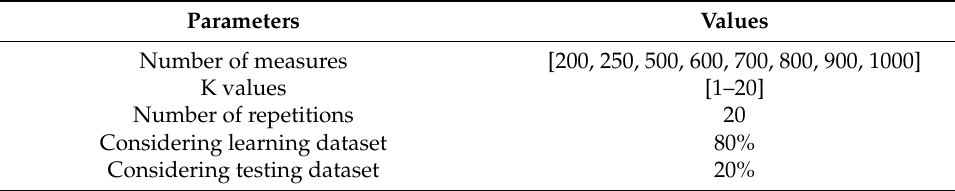
Table 3. Parameters used to find best K